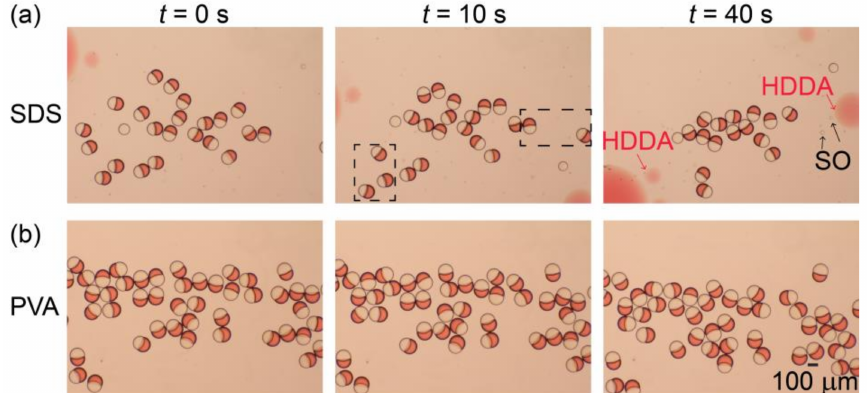
Figure 5. Off-chip stability of Janus droplets. ( a,b ) Comparison of off-chip stability between ( a ) surfactant-free Janus droplets dispersed in aqueous sodium dodecyl sulfate (SDS) solution and ( b ) Janus droplets containing 0.1 wt.% surfactant in their silicone-oil segments dispersed in aqueous PVA solution. Both droplets were produced at Q m = Q s = 0.3 mL h − 1 , and Q c = 8.0 mL h − 1